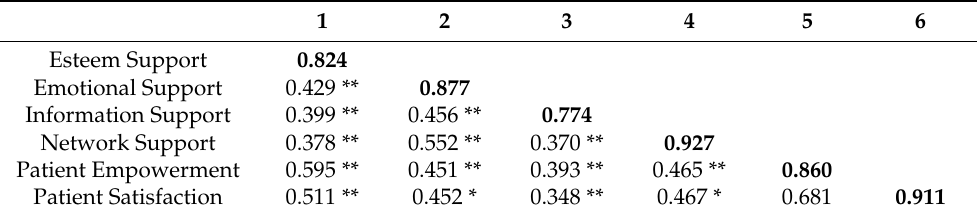
Table 5. Correlation